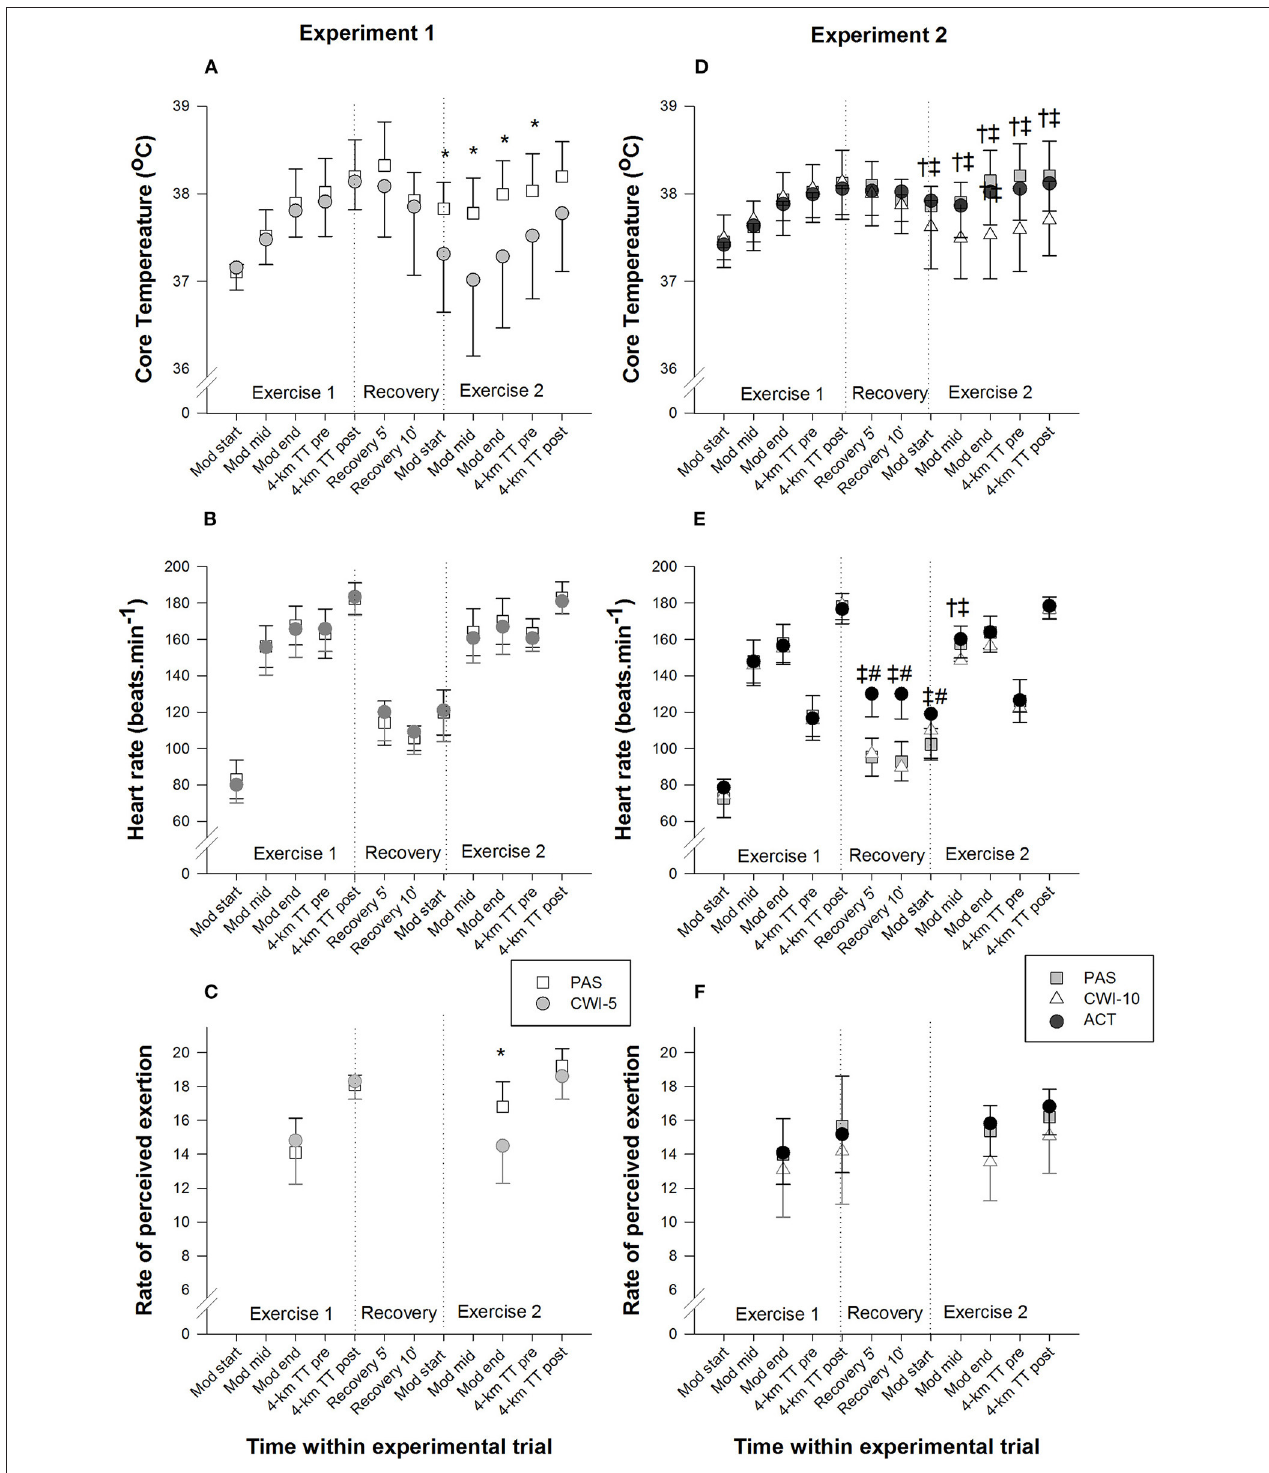
FIGURE 3 | Mean ( ± SD) core temperature ( A , Experiment 1 ; D , Experiment 2 ), heart rate ( B , Experiment 1 ; E , Experiment 2 ) and ratings of perceived exertion ( C , Experiment 1 , F , Experiment 2 ) responses at different time points during the experimental conditions. PAS, passive recovery; CWI-5, 5min cold water immersion; CWI-10, 10min cold water immersion; ACT, active recovery; Mod, 12-min moderate-intensity constant-load exercise; mid, mid time point; TT, time trial. *CWI-5 significantly different from PAS ( P < 0.05). † CWI-10 significantly different from PAS (P < 0.05). ‡ CWI-10 significantly different from ACT ( P < 0.05). # Active recovery significantly different from PAS ( P <